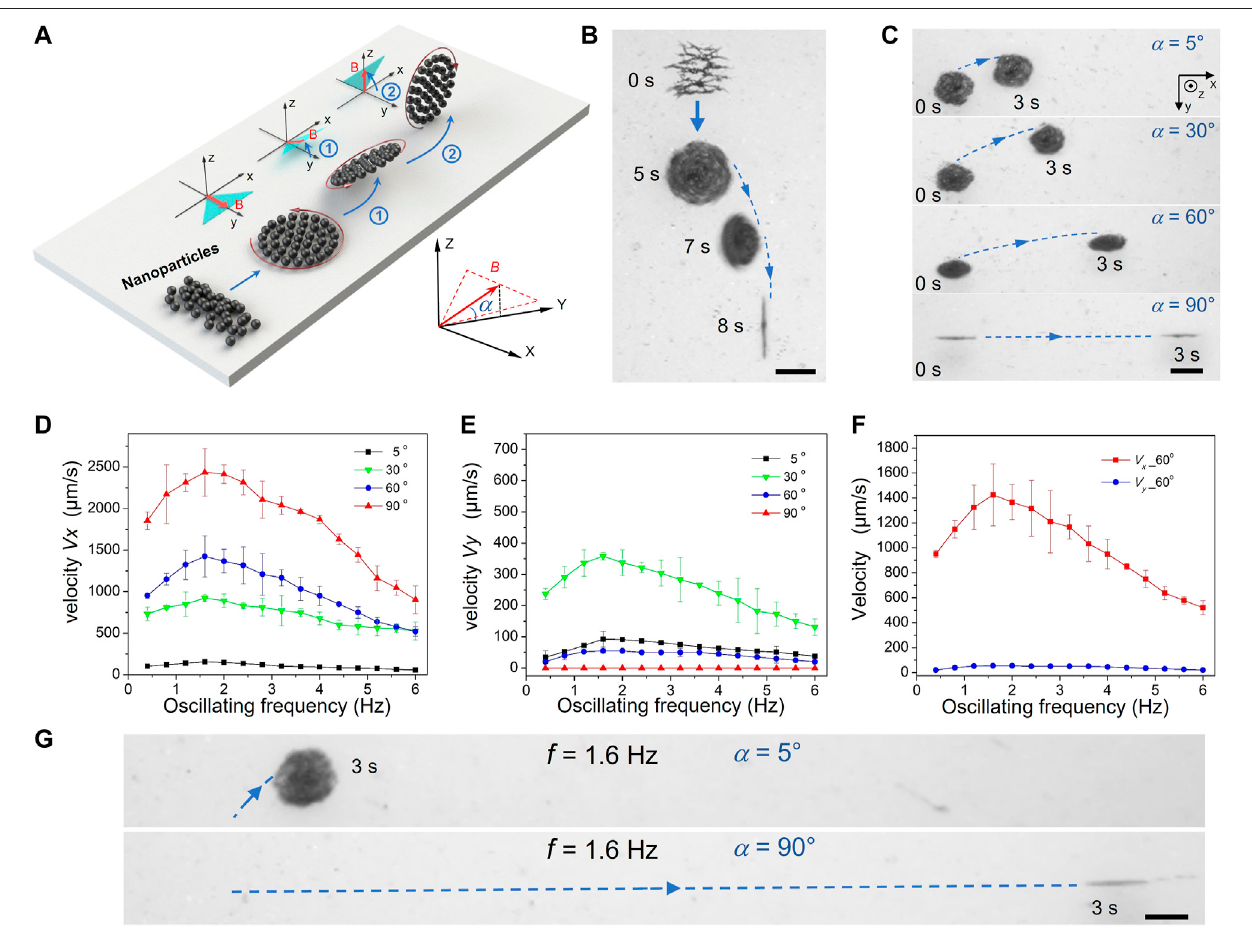
FIGURE 3 | Wheel-like swarms with enhanced maneuverability and locomotion speed. (A) Schematics and (B) Overlaid optical micrographs of the generation process of a vertical wheel-like swarm actuated by programming sawtooth fi elds. The blue arrow lines represent the desired swarm paths. The α denotes the dihedral angle between magnetic- fi eld plane and the xoy plane. The scale bar is 250 μ m. (C) Trajectory tracking of tilting wheel-like swarms at α = 5 ° , 30 ° , 60 ° and 90 ° .The scale bar is 200 μ m. Variations of (D) the advancing velocity Vx and (E) the side-slipping velocity Vy with the fi eld frequency f at different inclination angle α . (F) Comparisonchartoftheadvancingandside-slippingspeedoftiltingwheel-likeswarmwithaninclinationangle α = 60 ° . (G) Comparisonchartofthedisplacementsofthe vertical wheel-like swarm and the horizontal swam. The scale bar is 300 μ